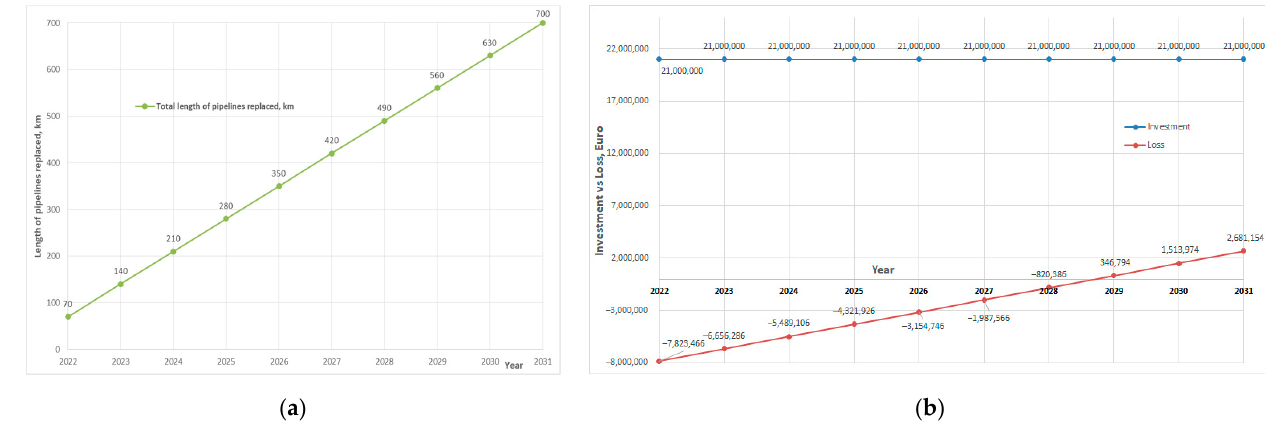
Figure 13. Lengths replaced, amounts invested and reduction of losses—scenario 2: ( a ) planning lengths to be replaced, km; ( b ) investment costs and loss mitigation, EUR (source: authors based on the analysed data).